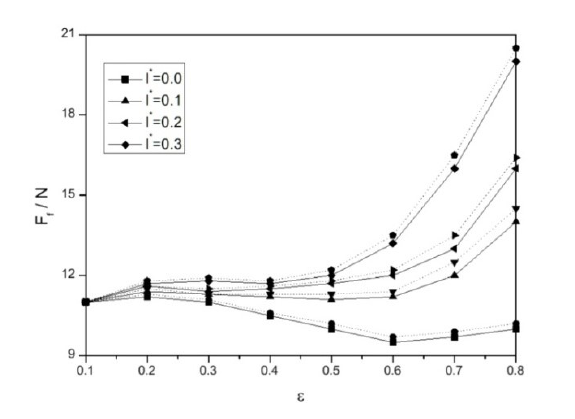
Fig. 3: Shaft temperature versus eccentricity ratio for different val- ues of the couple stress parameter with roughness parameter 0.1